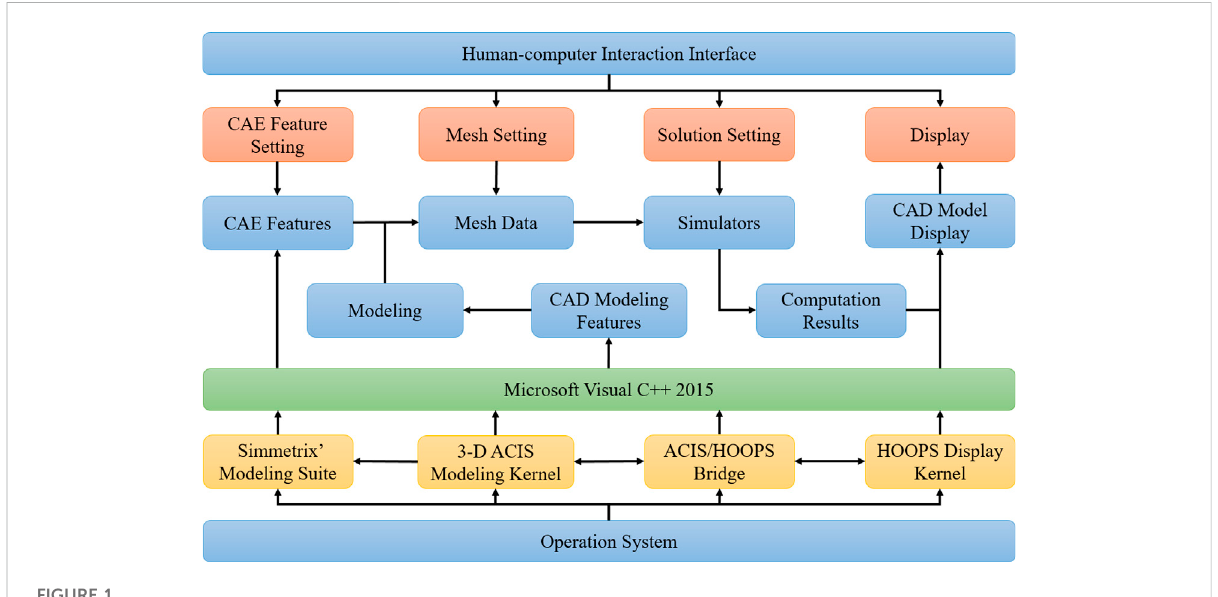
FIGURE 1 Architecture of the terminal simulation tool.